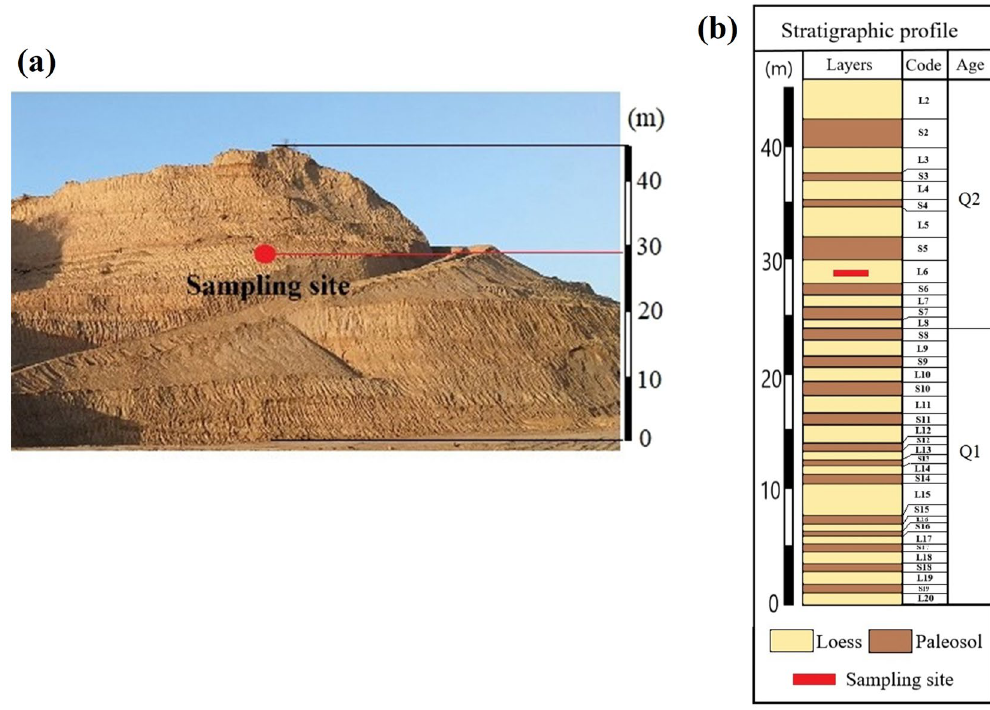
Figure 5. Location of the sampling site: ( a ) the sampling site in the excavated slope profile; ( b ) stratigraphic profile of the excavated slope.